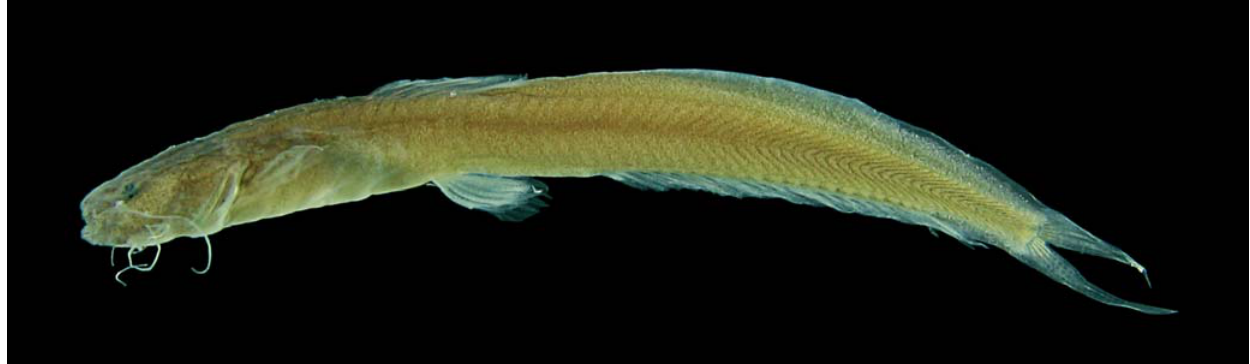
Fig. 1. Gladioglanis anacanthus , holotype, INPA 28446, 26.3 mm SL, Brazil, Amazonas, Novo Aripuanã, rio Aripuanã, lake inside Mamão Island. Photograph by R. R. de Oliveira.